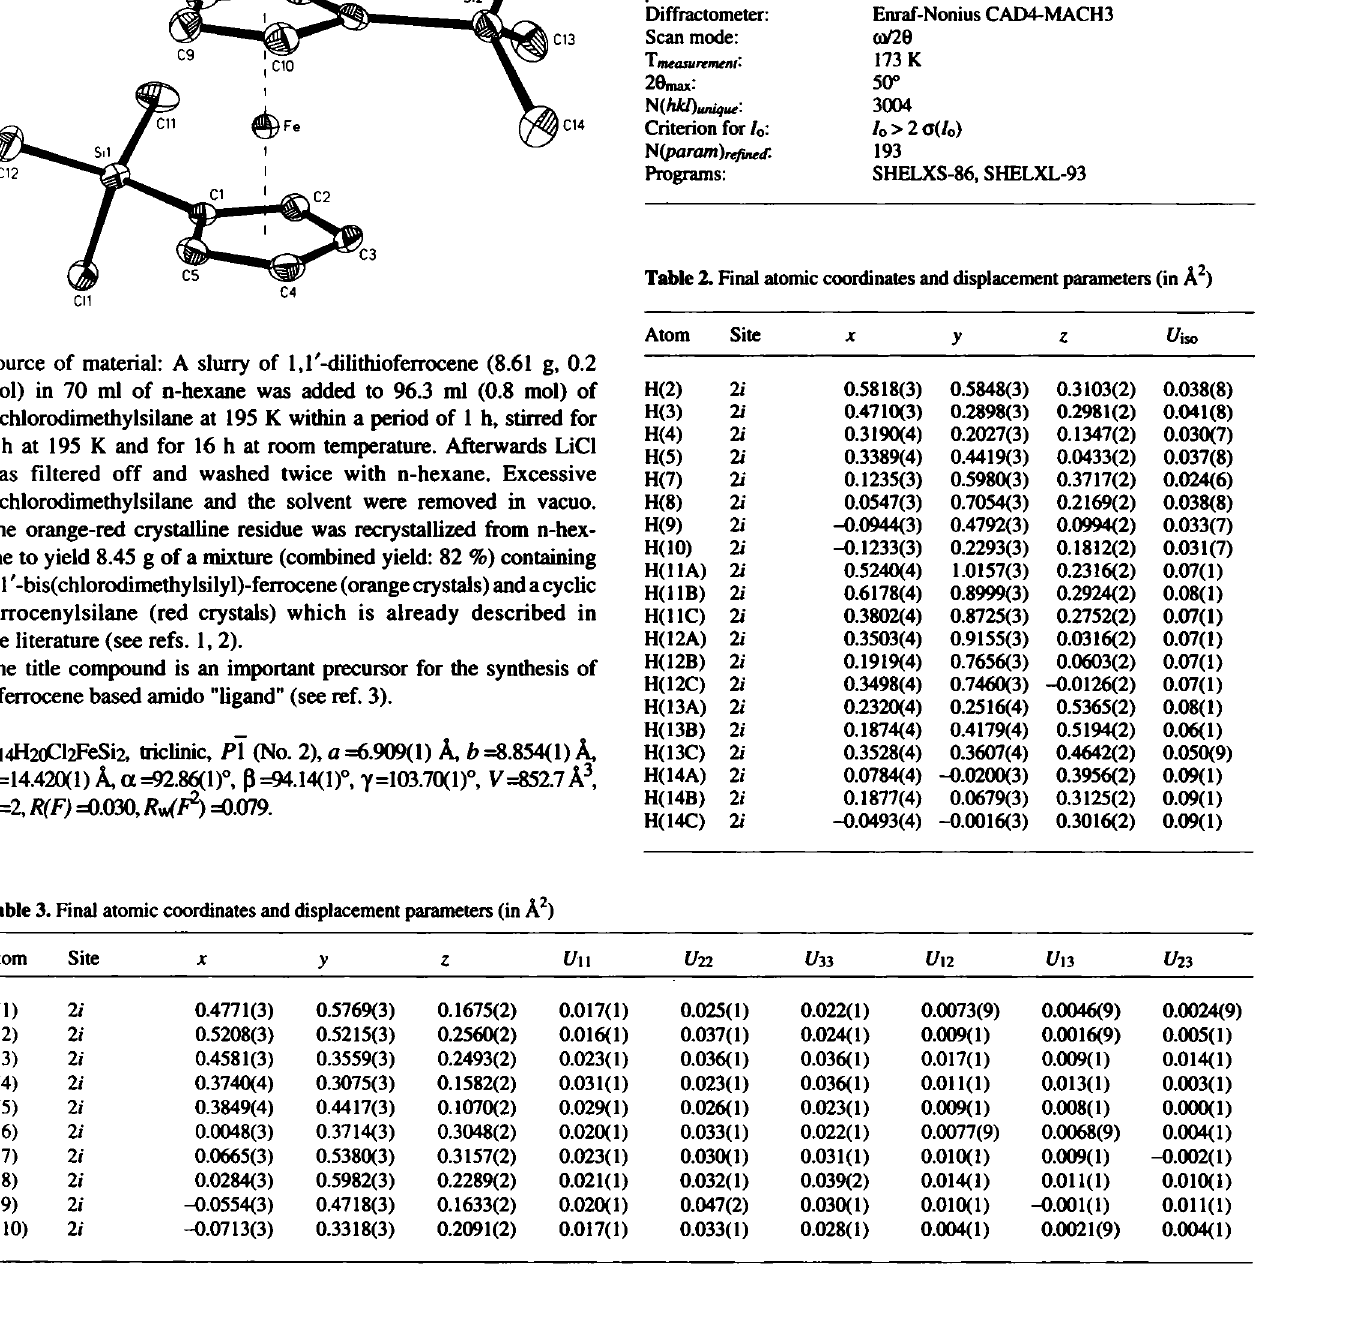
Table 1. Parameters used for the X-ray data collection